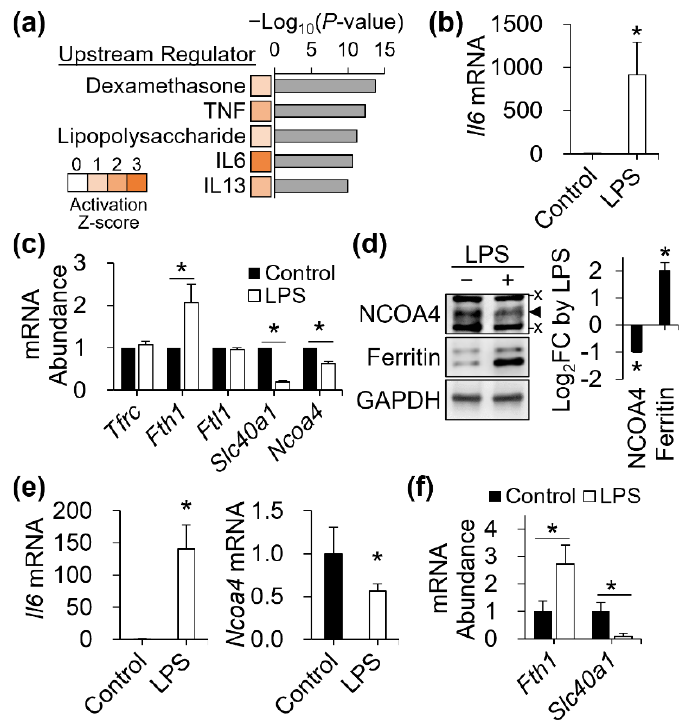
Figure 7. LPS downregulates NCOA4 at the transcript level in vitro and in vivo. ( a ) Top five most significant upstream regulators explaining the gene responses produced by NCOA4 deficiency in J774 cells. The positive activation score > 2 of IL6 predicts its activation in NCOA4-deficient cells. ( b ) Enhanced Il6 transcript abundance by LPS in J774 macrophages ( n = 4 independent experiments). ( c ) Responses of Ncoa4 , Fth1 , and Slc40a1 transcripts to LPS in vitro ( n = 4 independent experiments). ( d ) Repression of NCOA4 and elevation in ferritin proteins by LPS in J774 cells ( n = 3 independent experiments). ( e ) Upregulation of Il6 and downregulation of Ncoa4 transcripts in the spleen of male mice after 6 h of intraperitoneal LPS injection ( n = 5 animals per group). ( f ) LPS-induced responses of splenic ferritin-H ( Fth1 ) and ferroportin ( Slc40a1 ) transcript abundance ( n = 5 animals per group). All qPCR data were normalized to normalized to Actb . Data presented as mean ± SD. *, p < 0.05. x, non-specific band. ◄ , NCOA4 band.